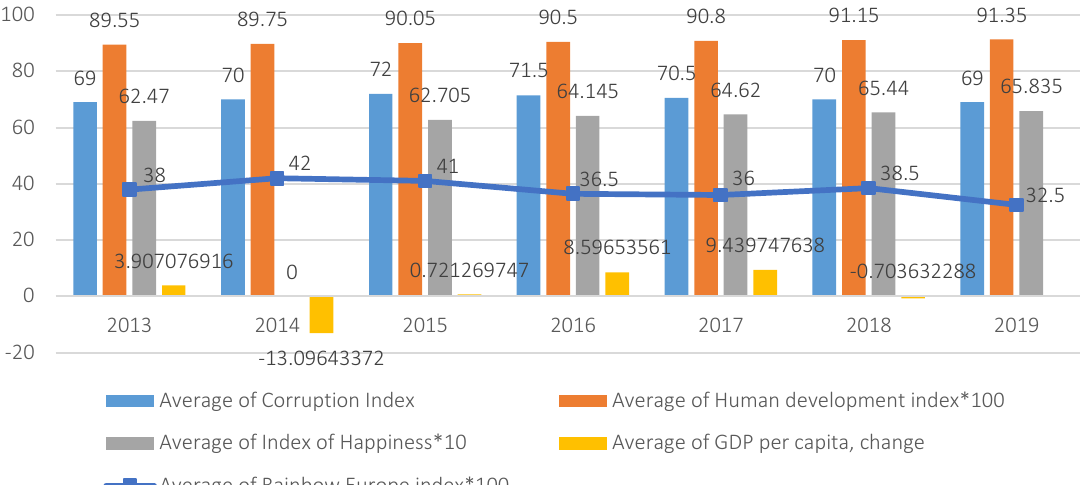
Figure 3. Average values of given indicators with a clear line of Rainbow Europe Index for Germany and Poland